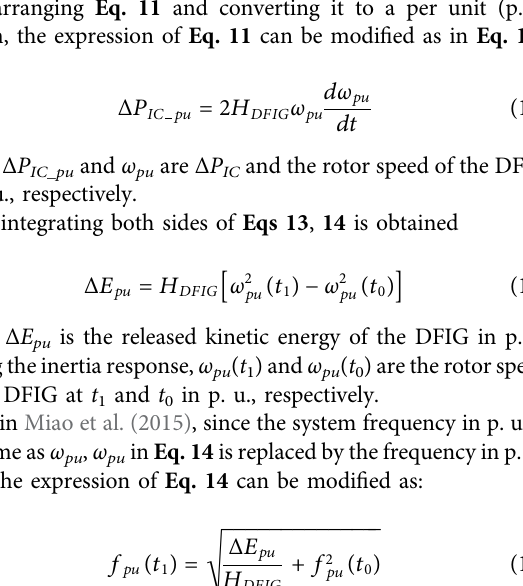
Frontiers in Energy Research |